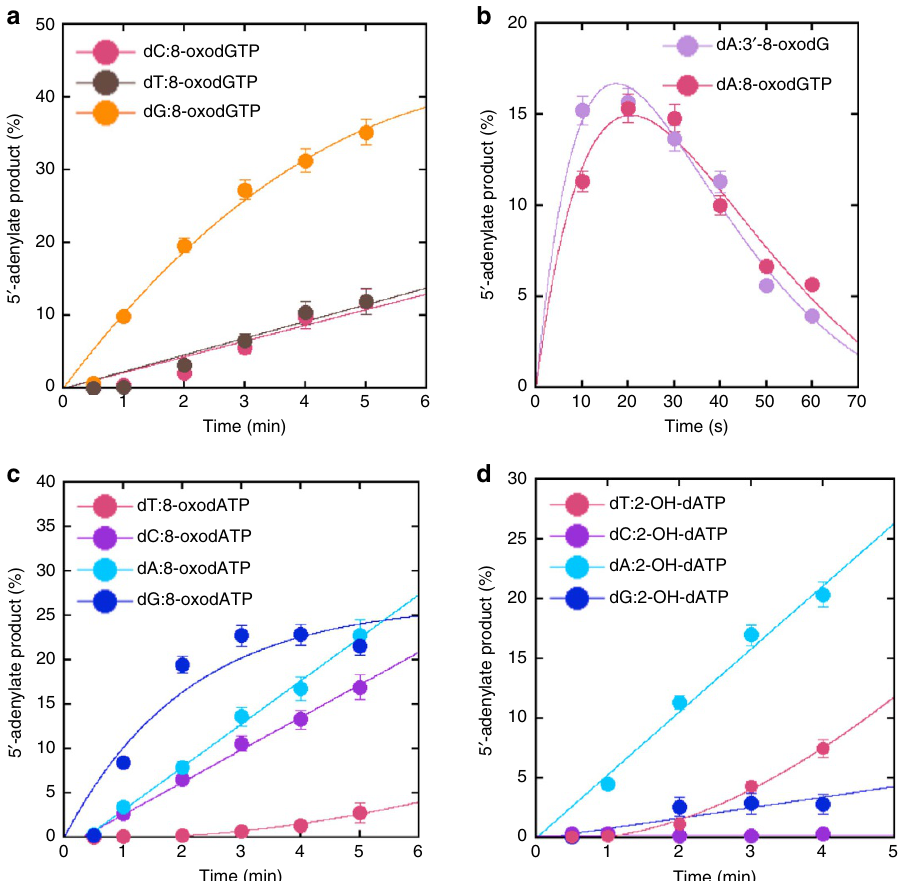
Figure 6 | Template base and oxidized nucleotide-dependent comparison of ligation failure. Plots show template base-dependent changes in the products of 5’-adenylation for the substrates C gap , G gap , and T gap ( a ), A gap and A nick ( b ), oxidized nucleotide and template base-dependent changes in the products of 5’-adenylation for 8-oxodATP ( c ) and 2-OH-dATP ( d ) for the substrates A gap , C gap , G gap and T gap . Time-dependent changes in ligation products are presented in Supplementary Fig. 1b–d. The data represent mean values with the s.d. from three independent